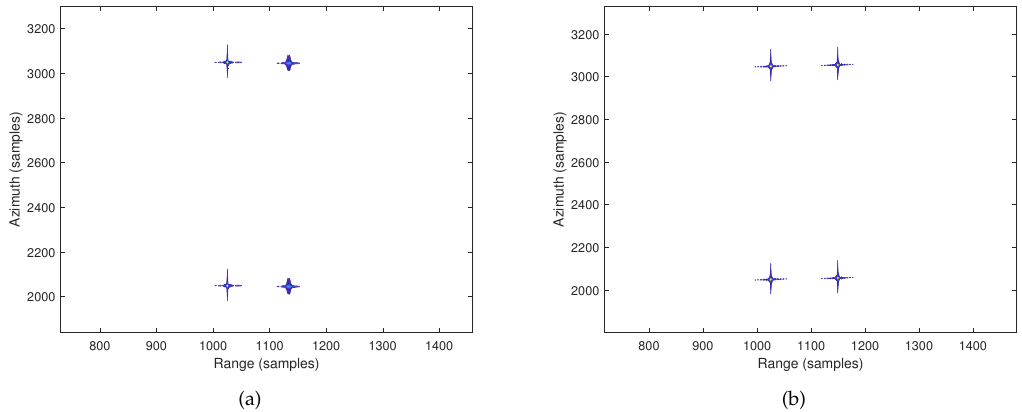
Figure 5. Imaging results. ( a ) Imaging results of the traditional hyperbolic omega-K algorithm. ( b ) Imaging results of the proposed hyperbolic omega-K algorithm.